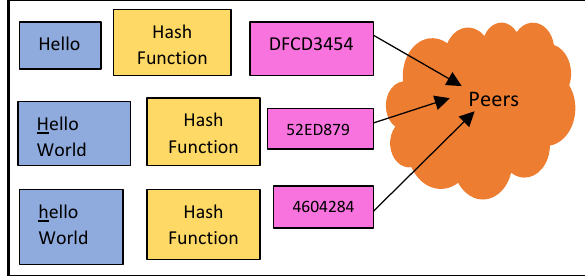
Fig. 3.2 Working of hashing in